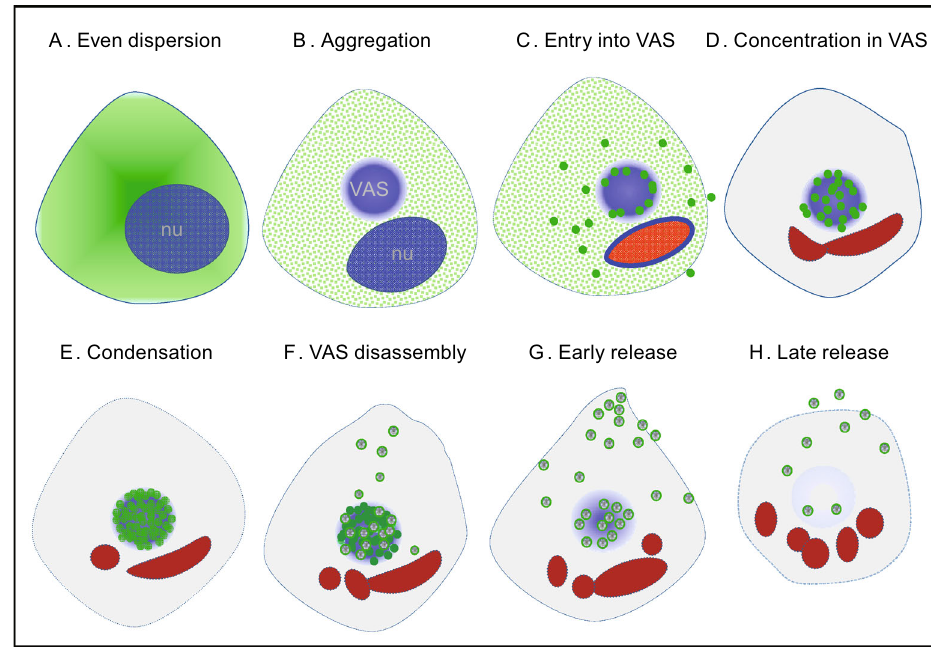
Figure 6. Representative stages of VAS formation and disassembly. VP88GFP distributes evenly in the endoplasm. In SGIV- infected cells, VAS forms in a perinuclear area rich in viral DNA, which exhibits strong staining with Hoechst 33342 (blue) as the nucleus (nu). VP88GFP is recruited into VAS and condensed there for assembly and maturation. VAS disassembly occurs when matured virus particles are released out of the host cell. SGIV infection induces host cell death, resulting in nuclear fragmentation and cell membrane leakage permissive to staining by DNA dye PI